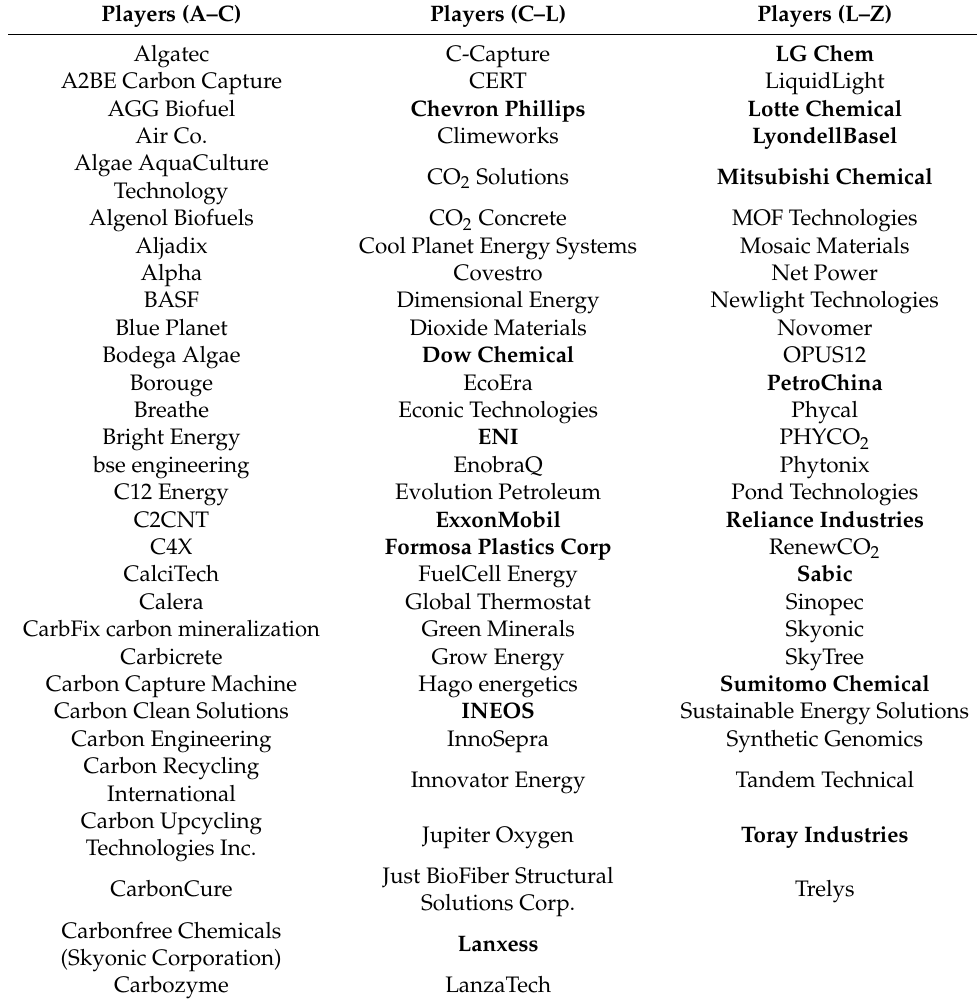
Table 3. Identified players and startups that are active in the field of carbon capture and utilization (CCU) techniques for the plastics industry.